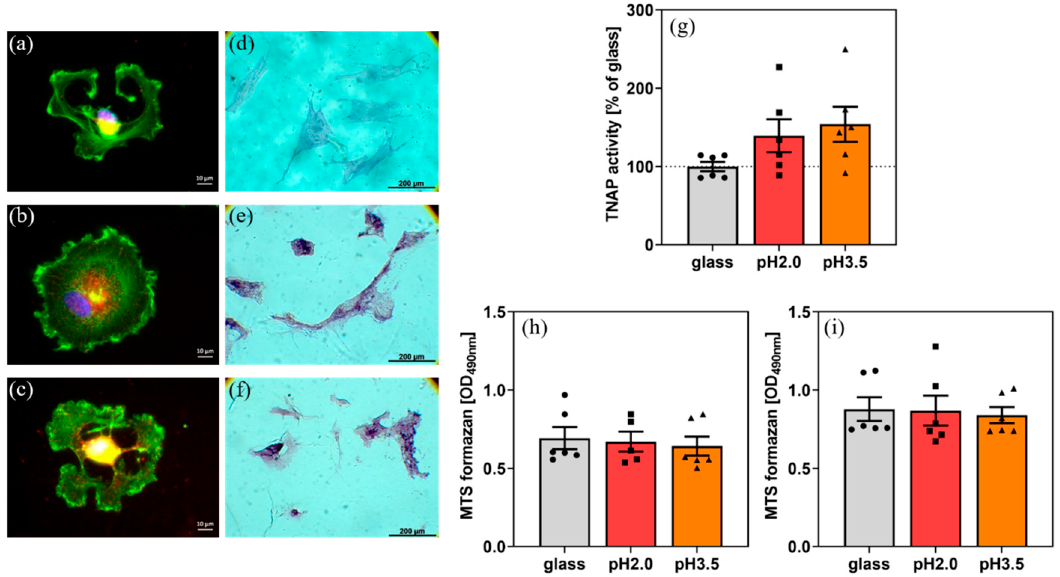
Figure 3. ( a ) Morphology of human bone marrow stromal cells (hBMSC) on ( a ) glass, ( b ) fibrillar coating (pH = 2), ( c ) fibrillar coating (pH = 3.5), 2 h after plating, and ( d , e , f ) TNAP staining at day 11 after plating, respectively. ( g ) TNAP activity on different substrates (day 11) and metabolic activity results at ( h ) day 2 and ( i ) day 4 after plating.